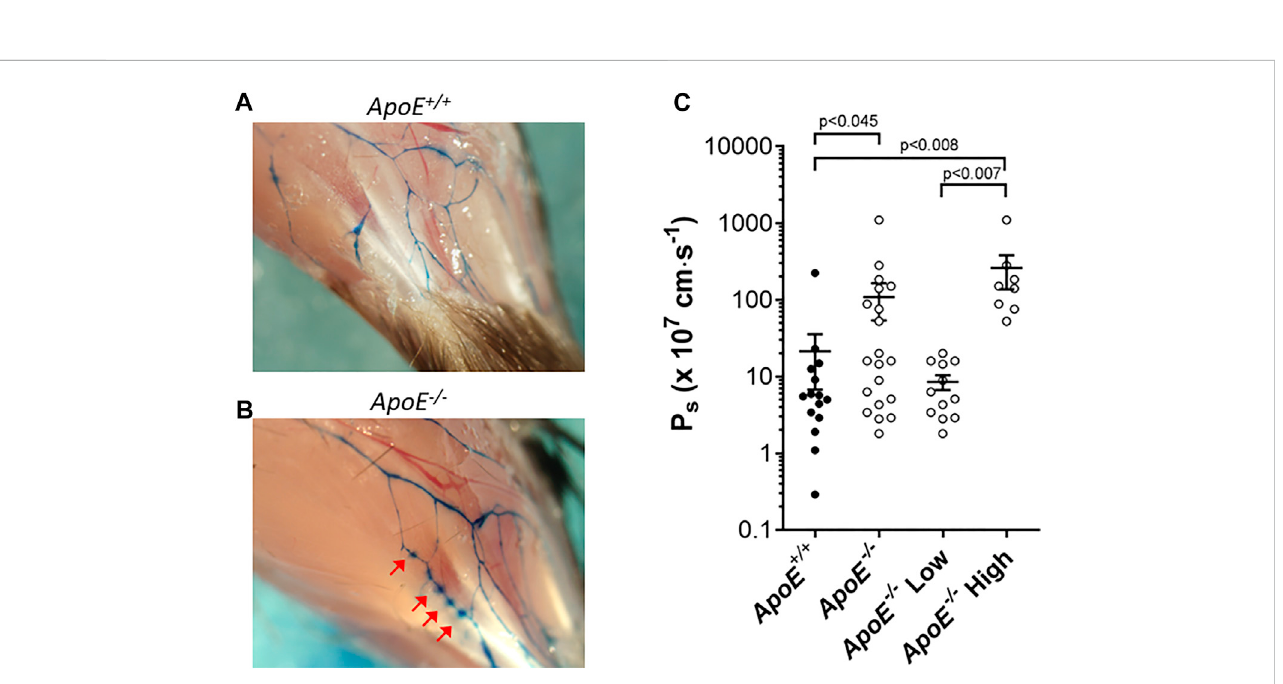
FIGURE 5 ApoE − / − vesselsexhibithyperpermeability. (A – B) IncreasedleakofEvan ’ sBluedyeisevident invivo in ApoE − / − vessels (B) comparedto ApoE +/+ vessels (A) . Arrowsmarksitesofleakage. (C) Exvivo quanti fi cationofalbuminpermeability(P s )for ApoE +/+ vessels(n=15)and ApoE − / − vessels(n=20).Theaverageswere 21×10 – 7 cm/svs.109×10 – 7 cm/sforthecontrolsvs.knockouts,respectively,whichwassigni fi cantlydifferentbasedonaMann-Whitneytest.Therewashigh variability in the ApoE − / − group, with 8 of 20 ApoE − / − vessels having severely elevated permeability (statistically signi fi cant by Mann-Whitney test) compared to ApoE +/+ vessels when the data were split into subpopulations, and 12 of 20 vessels were within the range of ApoE +/+ vessels (not signi fi cantly different by Mann-Whitney